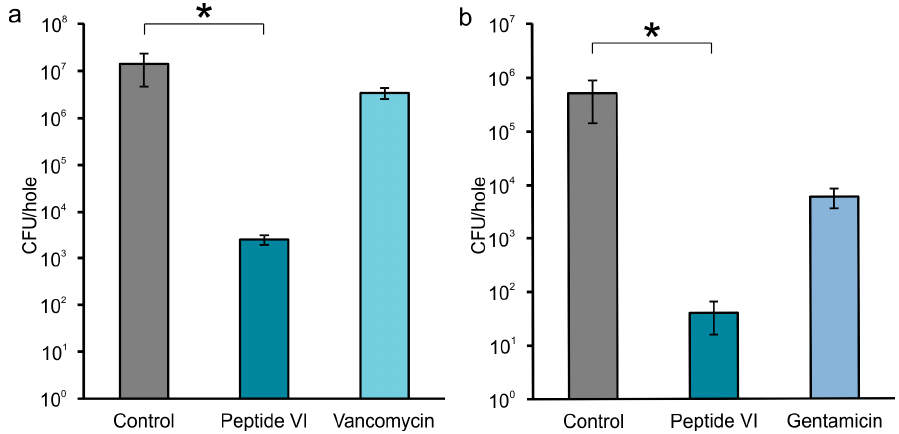
Figure 2. Antimicrobial activity of peptide VI compared to antibiotics against S. aureus (MRSA 6271) and S. epidermidis (clinical isolates) assessed in the bone samples. The infected holes were treated with the ChronOS Inject carrier (200 mg) blended with peptide VI (10 mg) or antibiotics (10 mg). Carrier alone was used as a control. ( a ) peptide VI vs. vancomycin against S. aureus ; ( b ) peptide VI vs. gentamicin against S. epidermidis . The bars represent mean value ± SEM at least from three independent measurements. Statistical differences between groups were calculated using one-way ANOVA (* p < 0.05).